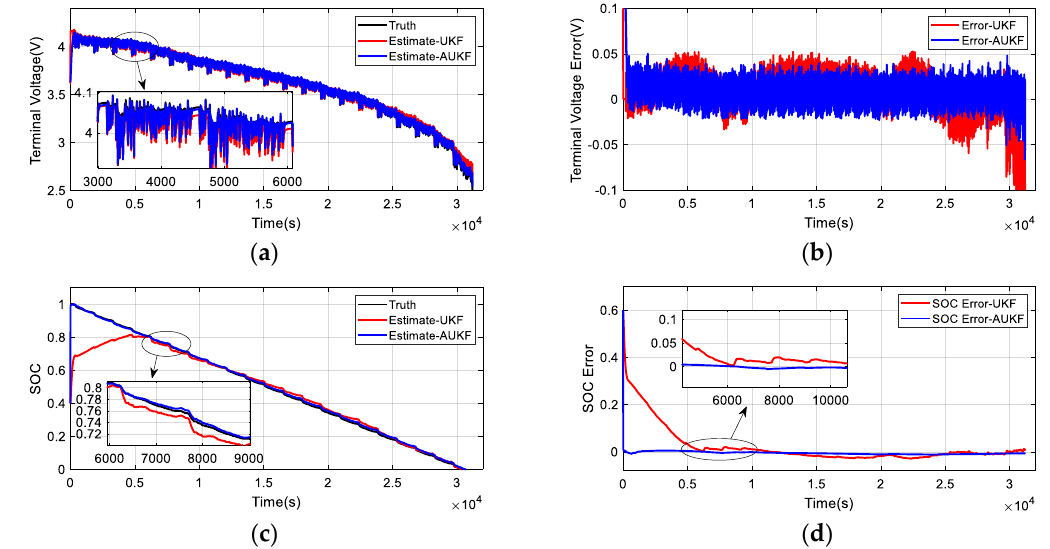
Figure 17. For the initial SOC = 0.4, the comparison of the estimation results of the UKF algorithm and the AUKF algorithm under UDDS discharge conditions. ( a ) Comparison of terminal voltage. ( b ) Comparison of terminal voltage errors. ( c ) Comparison of SOC. ( d ) Comparison of SOC errors.